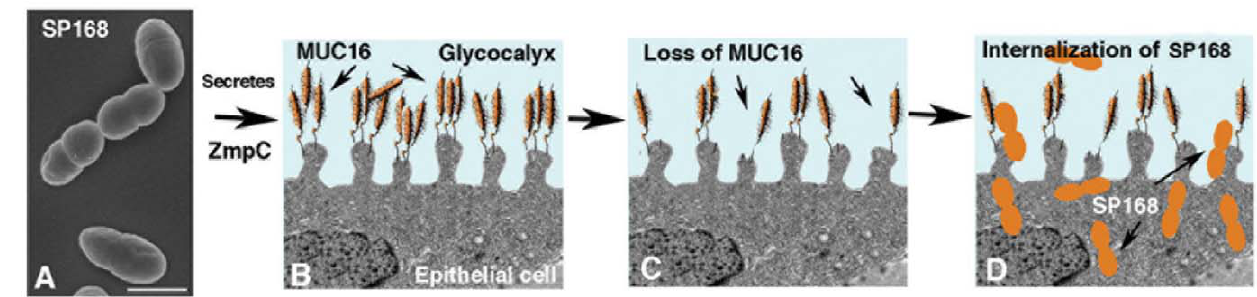
Figure 9. Diagram of the mechanism by which S. pneumoniae strain SP168 gains entry into epithelial cells. Scanning electron micrograph of S. pneumoniae strain SP168 ( A ), which secretes a zinc metalloproteinase, ZmpC, onto the apical surface of the epithelia ( B ), which has a glycocalyx rich in MUC16 transmembrane mucins that emanate from surface microridges (adapted from [47]). The secreted ZmpC induces MUC16 ectodomain release, causing a decrease in amount of MUC16 on the apical surface of the epithelium ( C ), that compromises the glycocalyx barrier integrity. S. pneumoniae , depicted in orange, is thus able to invade the epithelial cells due to the loss of MUC16 ( D ).